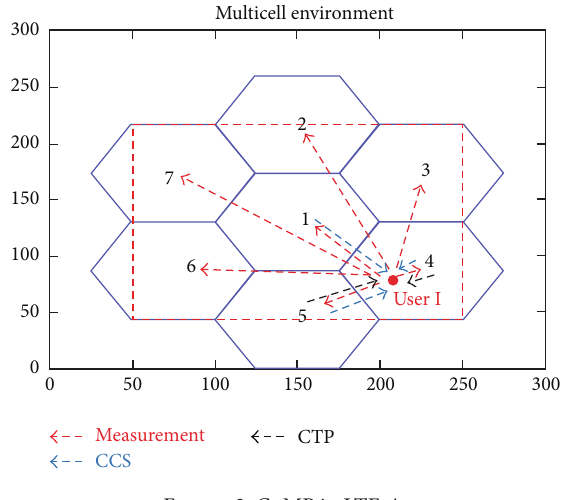
Figure 2: CoMP in LTE-A.